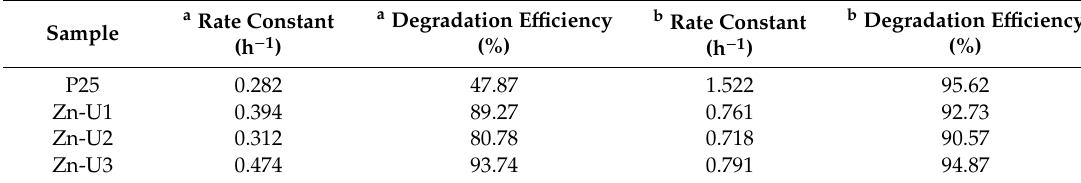
Table 2. Reaction rate constant and degradation e ffi ciency of the dyes: Methylene Blue a and Rose Bengal b .